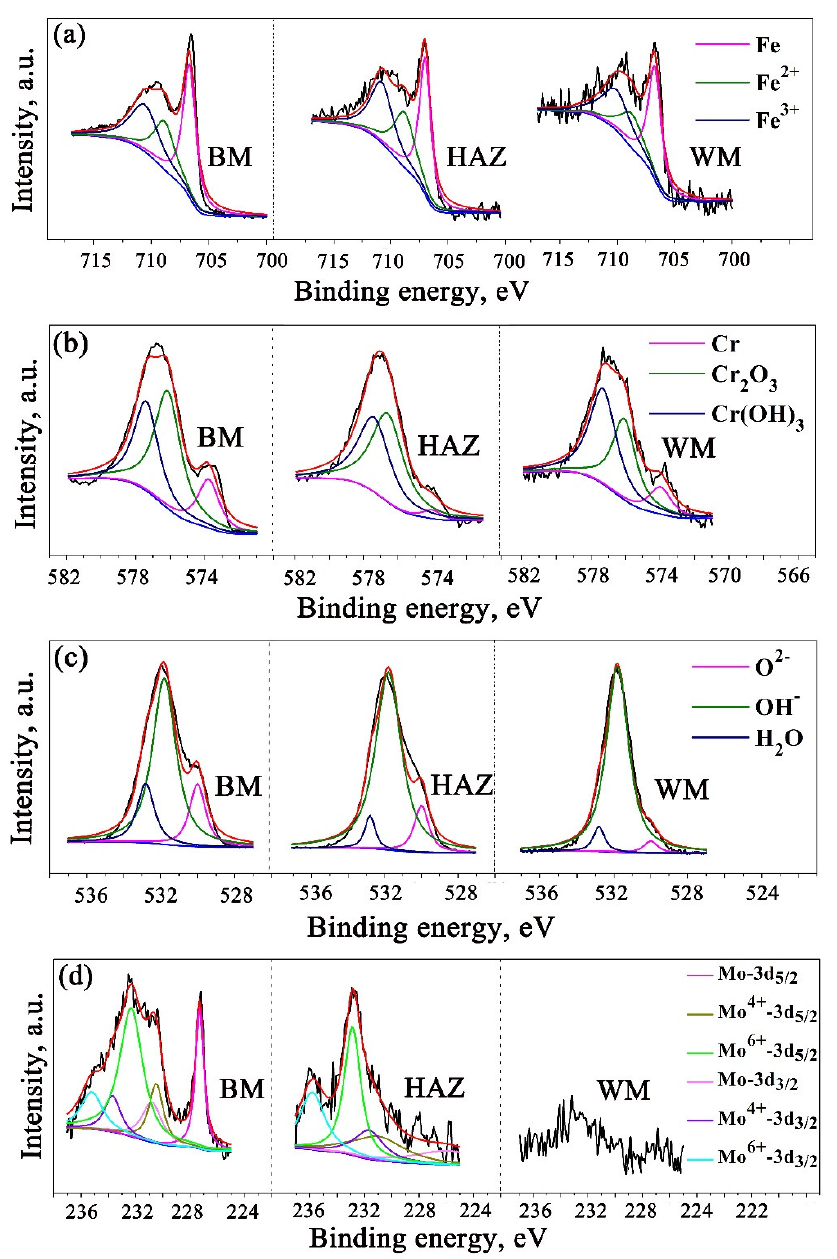
Figure 11. XPS spectra of ( a ) Fe 2p 3/2 , ( b ) Cr 2p 3/2 , ( c ) O 1s, and ( d ) Mo 3d in the passive film formed on BM, HAZ, and WM.